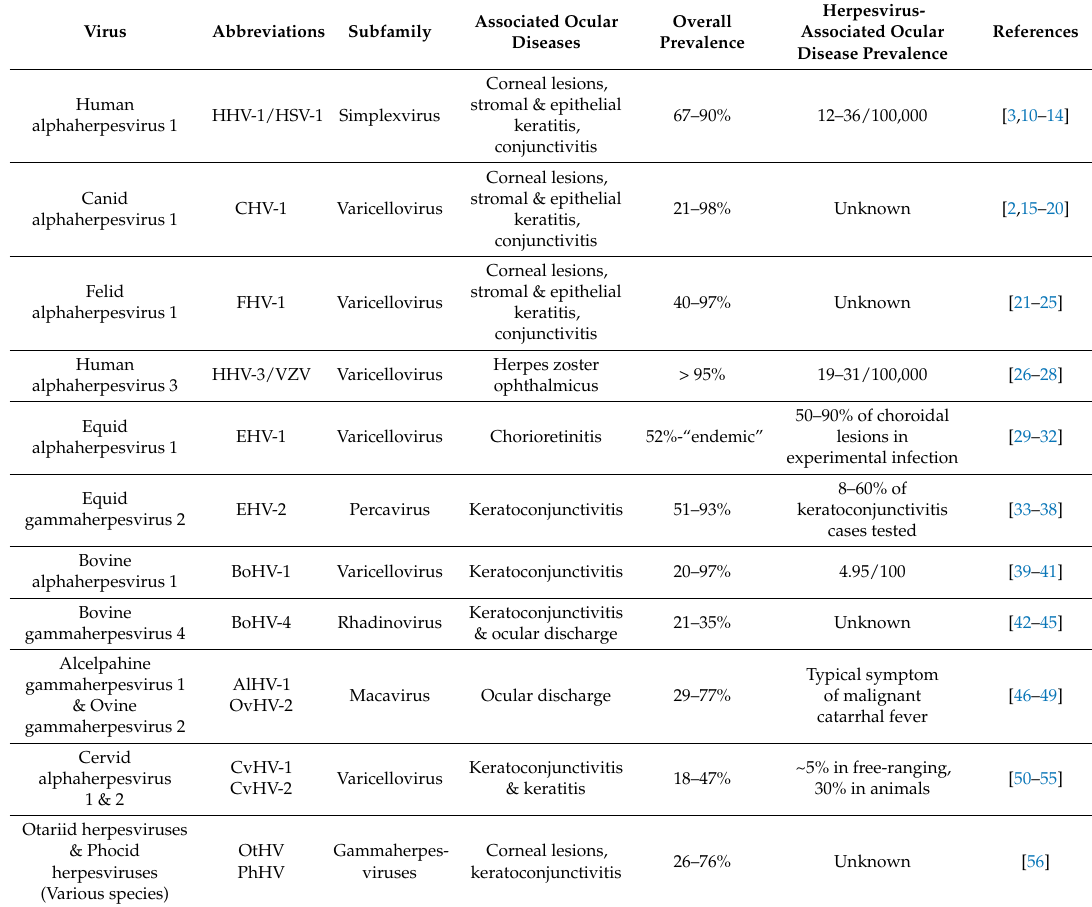
Table 1. Overview of herpesviruses reported in literature to frequently cause ocular